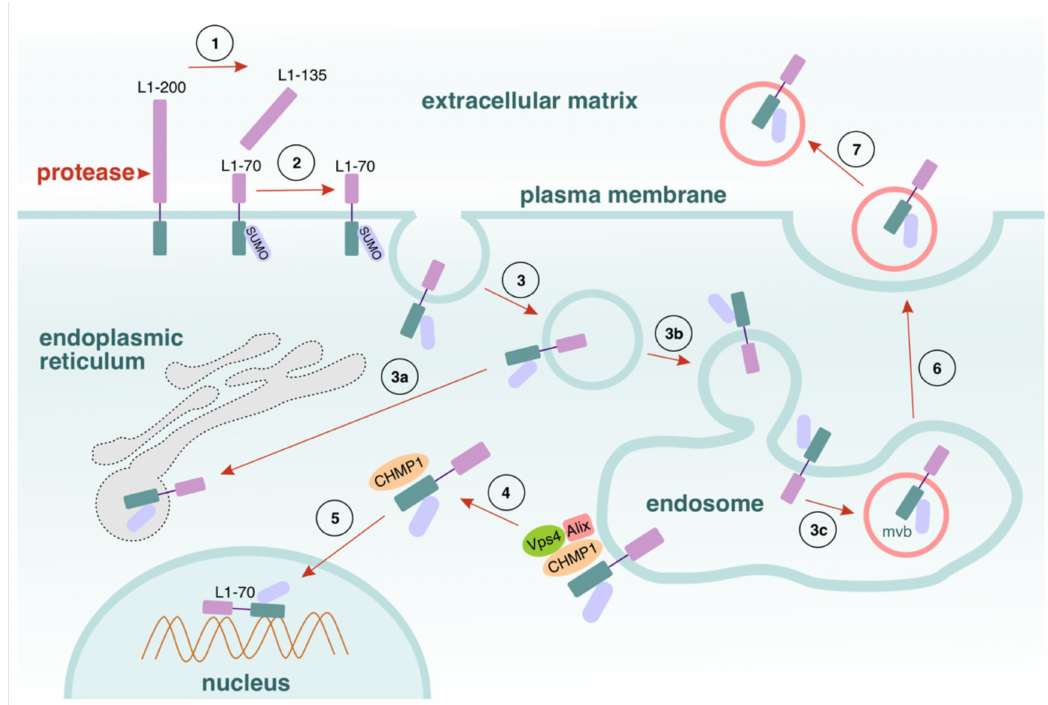
Figure 2. The formation, internalization, and intracellular pathways of L1-70. (1) Full-length L1 (L1-200) is cleaved by (serine) proteases into a membrane-bound 70 kDa L1 fragment (L1-70) and a soluble 135 kDa fragment (L1–135). (2,3) Via endocytosis, L1-70 enters the cytosol and it is then transported either to the endosomes or to the endoplasmic reticulum (3a, 3b). L1-70 is distributed to the endoplasmic reticulum, the sorting endosomes, and the late endosomes. (3c) L1-70 is loaded onto multivesicular bodies (mvb). (4) Once released from the endosomes, a process that depends on the ESCRTIII proteins Alix, Vps4, and CHMP1, and on a conjugation with CHMP1, L1-70 is translocated into the nucleus and associates with the chromatin (5). (6) Another possible direction for L1-70 trafficking is via exocytosis